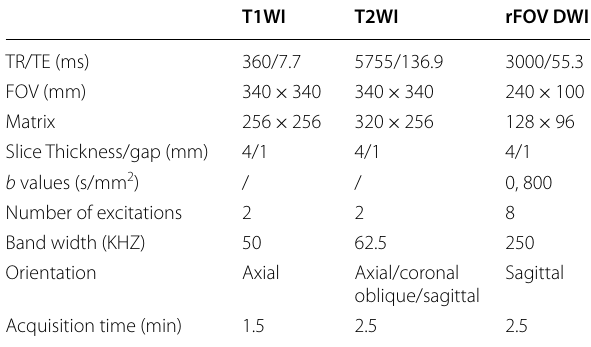
Table 1 The acquisition parameters of each imaging